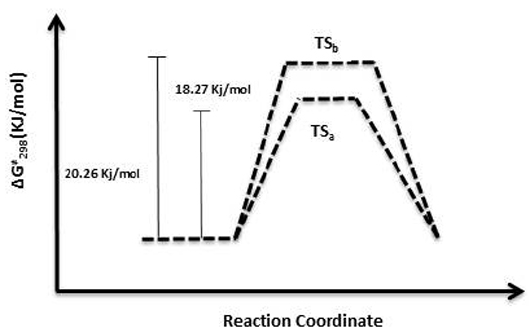
and TS , for the reaction steps a , and b ) calculated (Gaussian a b